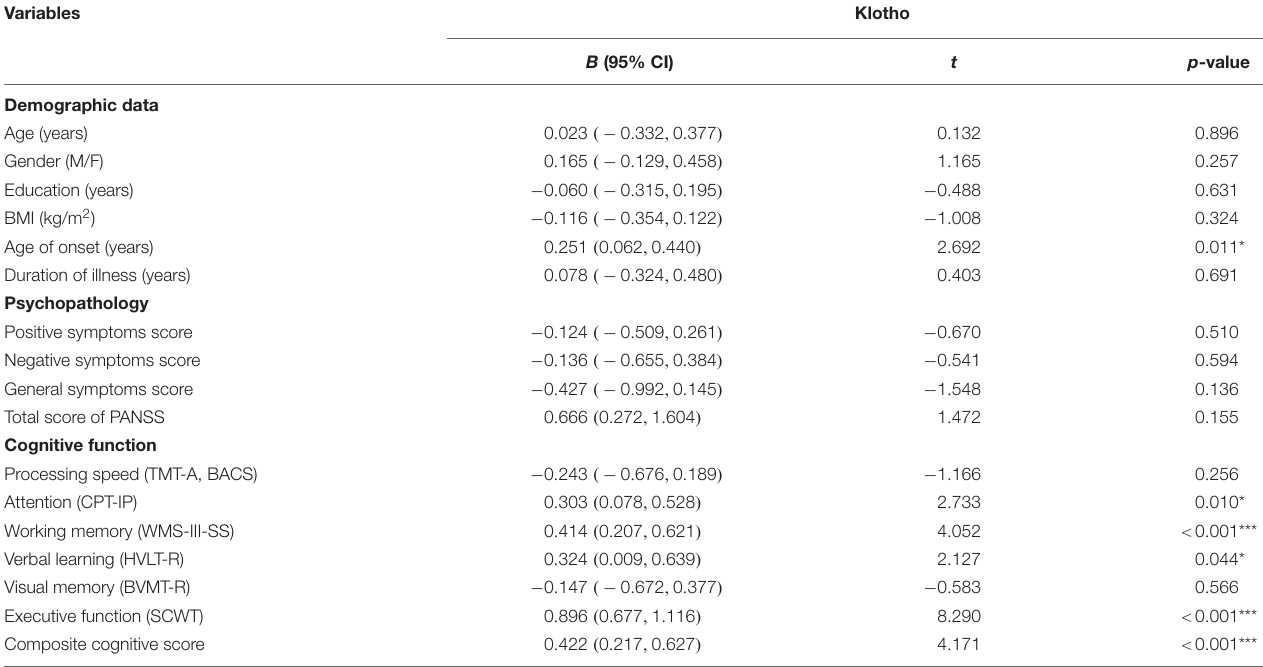
TABLE 2 | Correlations between plasma klotho levels, demographic variables, psychopathology and cognitive function in patients with schizophrenia ( n = 40).